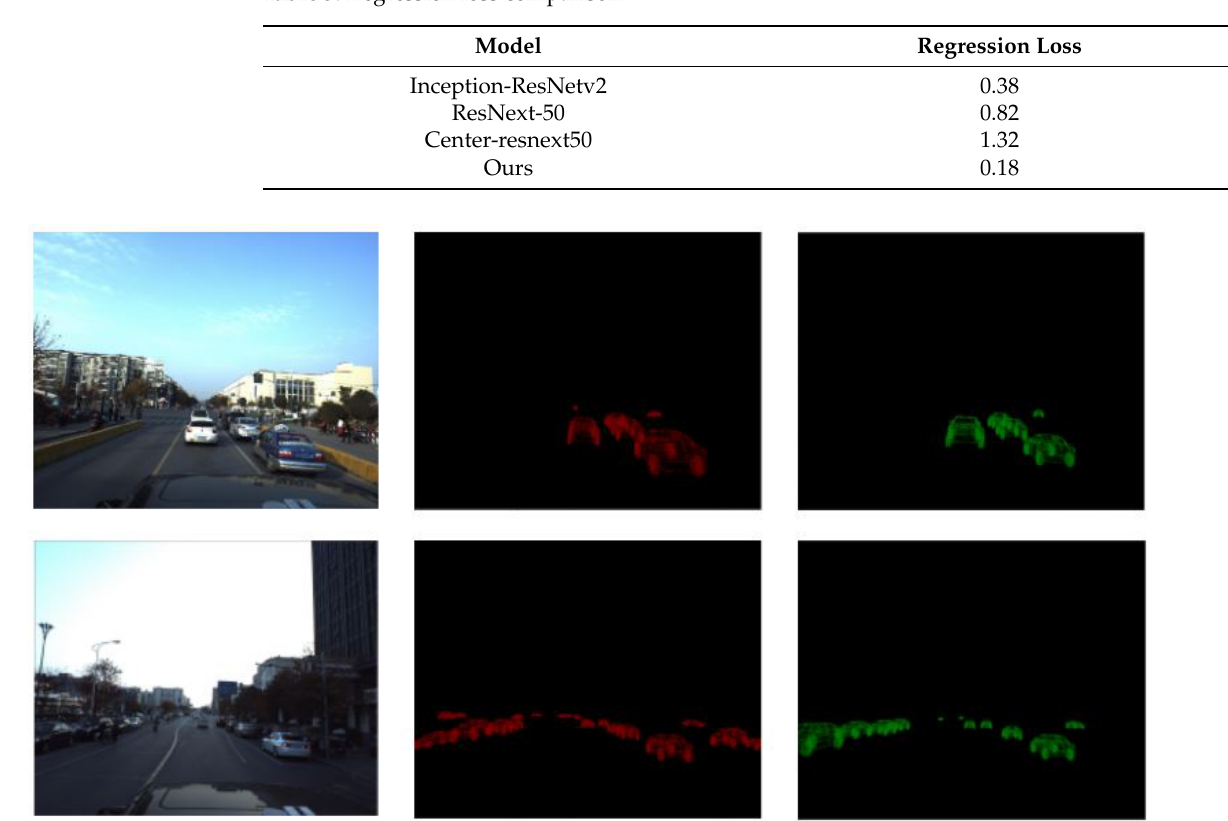
Table 3. Regression loss comparison.